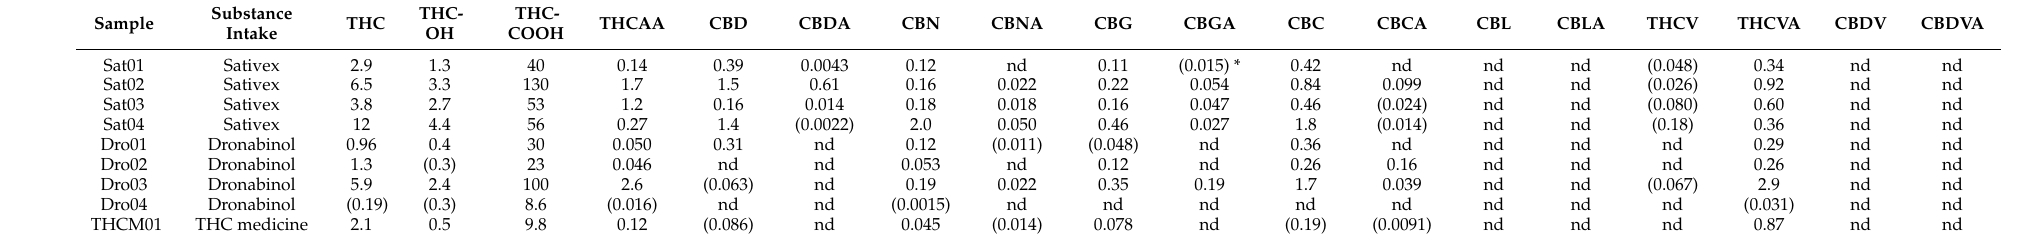
Table 3. Cannabinoid serum concentrations of forensic case serum samples with reported intake of cannabis-based medicines in [ng/mL].